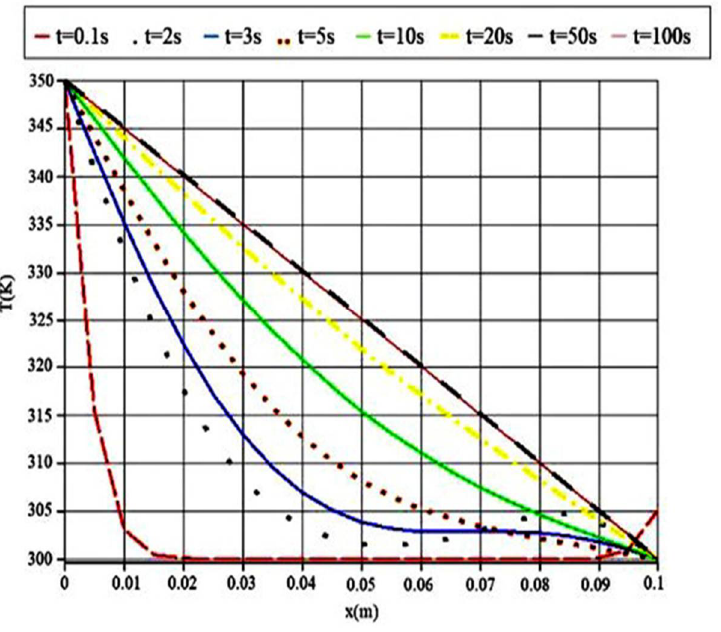
Figure 4. The temperature profile in various time steps.